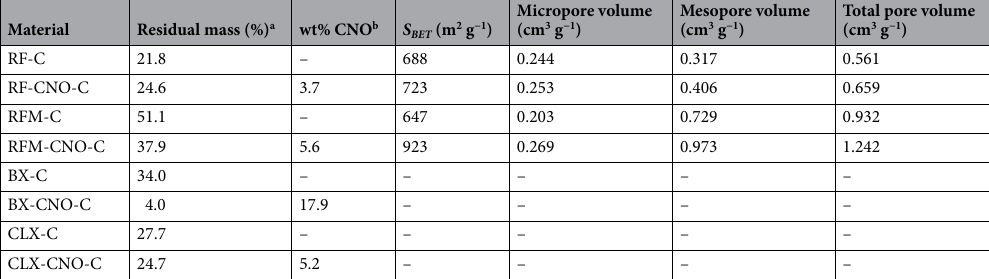
ments was defined due to the deconvolution of the high-resolution spectral regions C1s, O1s, and N1s (Fig. 5 and Figure S4, SI). The percentages and assignments of species are given in Table 2, while the details of curve fitting are summarized in Tables S2–S4, SI. The results indicate that all studied materials contain carbon atoms in the amount of 85–92% and oxygen in the amount of 6 to 13%. The RFM-CNO-C , BX-CNO-C , and CLX-CNO-C materials contain N atoms (2–4%, Table S1, SI), which is related to the presence of this element in the structure of the f -CNO and the resin’s substrates. All materials have a similar pattern of distribution of functional groups and defects. The peak at ∼ 284.3 eV can be assigned to the sp 2 hybridized C atom. The peaks at ∼ 284.9, ∼ 285.6, and ∼ 286.3 eV are related to the C–H sp 3 , C–C sp 3 , and C–OH or C–N moieties. The structures also contain negligible ether ( ∼ 287.0 eV) and carbonyl groups ( ∼ 287.8 eV). Interestingly, there are many vacancy-like defects in the graphitic lattice ( ∼ 283.8 eV) equal to 12–14% (Table 2 and Table S2, SI). An O1s XPS analysis shows that the ether and epoxy groups ( ∼ 532.7 eV) are dominant in RF-CNO-C , RFM- tion of N1s XPS spectral regions of RFM-CNO-C and BX-CNO-C indicates the presence of NH 2 ( ∼ 398.4 eV) and protonated amine ( ∼ 400.7 eV) in equal proportions. The XPS spectrum for CLX-CNO-C can be resolved